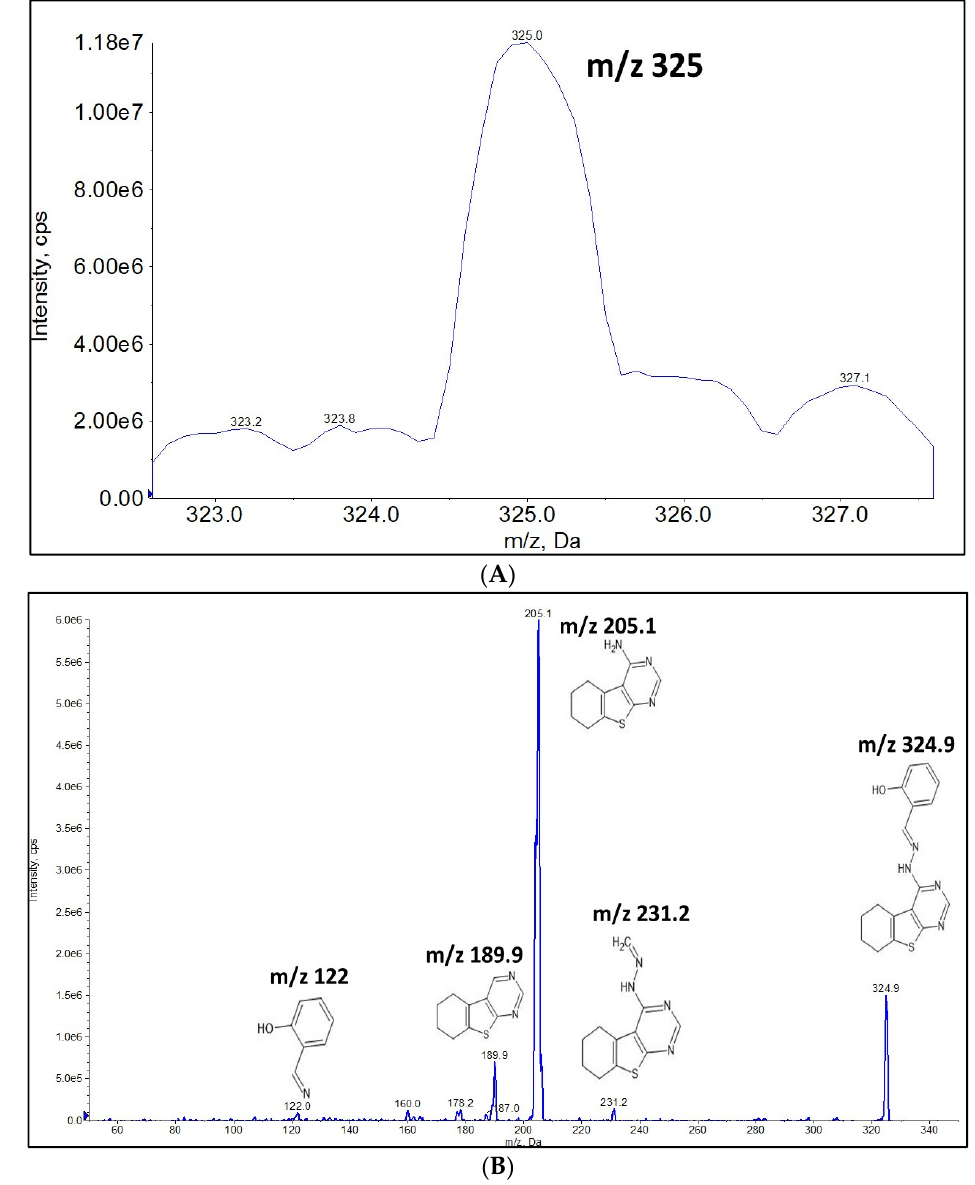
Figure 1 . ( A ) Q1 MS Spectra for OJT007. ( B ) MS2 Spectra for OJT007 . Figure 1. ( A ) Q1 MS Spectra for OJT007. ( B ) MS2 Spectra for